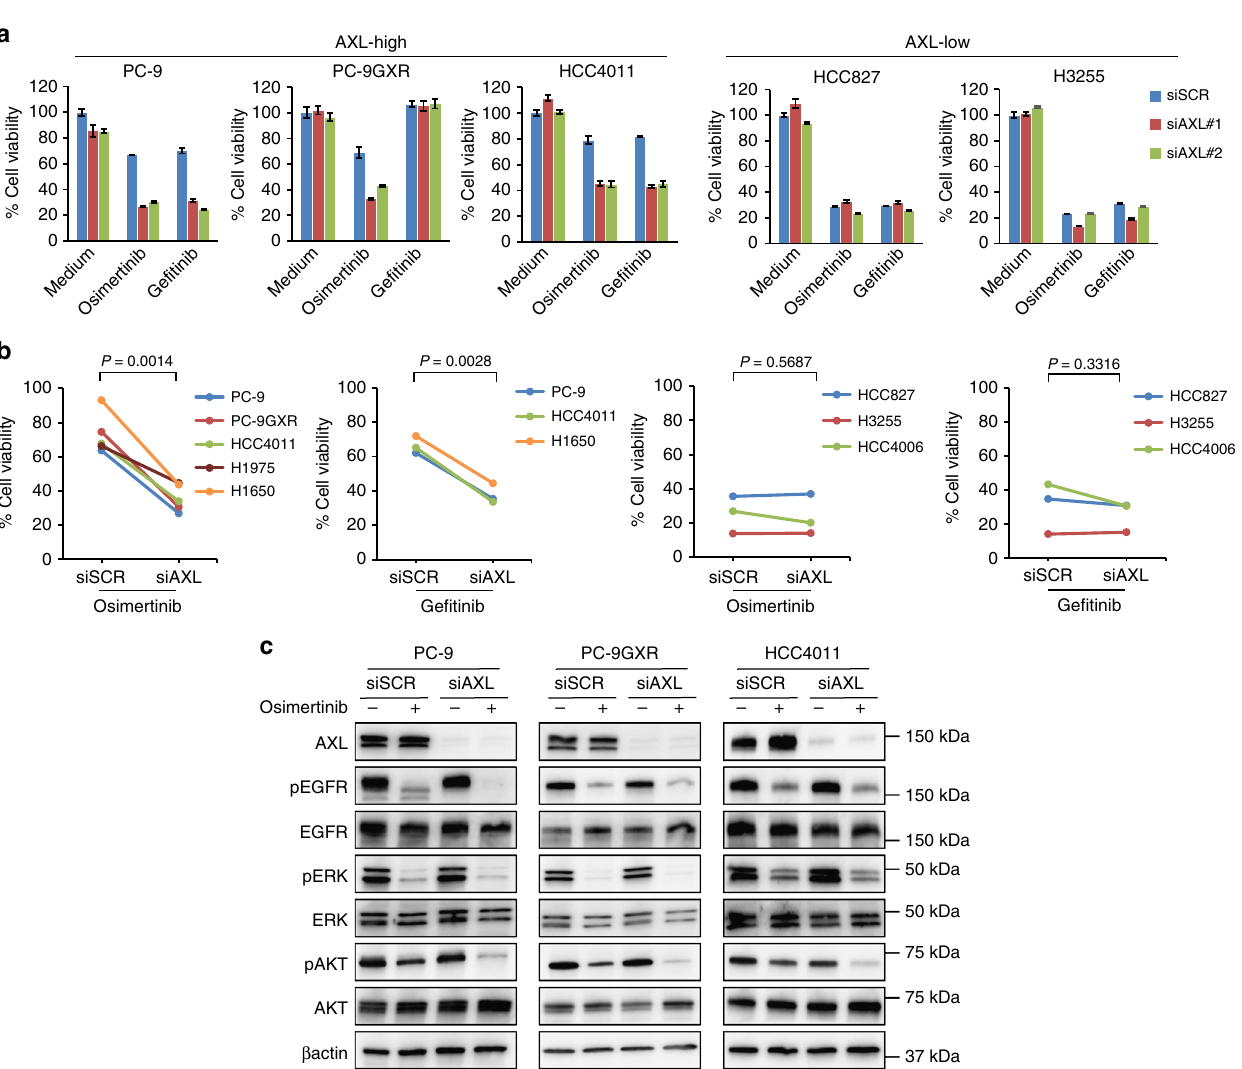
Fig. 3 AXL knockdown sensitized EGFR -mutated NSCLC cells to osimertinib in vitro. a Nonspeci fi c siRNA control or AXL -speci fi c siRNAs (#1 and #2) were introduced into PC-9, PC-9GXR, HCC4011, HCC827, and H3255 cells. After 24h, the cells were incubated with osimertinib (100 nmol/L) or ge fi tinib (100 nmol/L) for 72 h and the cell growth was determined using MTT assays. The percentage of growth is shown relative to the growth of untreated control cells. b Quantitative determination of the inhibition of cell viability of high-AXL-expressing and low-AXL-expressing EGFR -mutant cells transfected with nonspeci fi c siRNA control or AXL -speci fi c siRNAs after treatment with osimertinib or ge fi tinib. Paired Student ’ s t tests were used for comparisons. c Nonspeci fi c siRNA control or AXL -speci fi c siRNAs were introduced into PC-9, PC-9GXR, and HCC4011 cells. After 24 h, the cells were incubated with osimertinib (100 nmol/L) for 1 h. The cells were lysed and the indicated proteins were detected by western